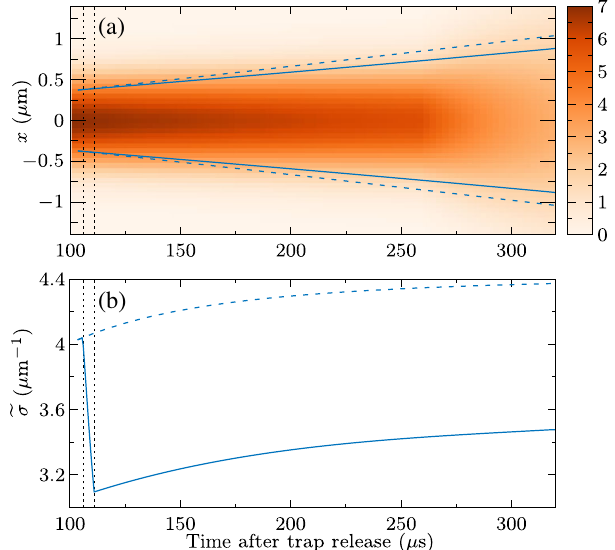
FIG. 6. Simulated expansion of a cloud of N ¼ 6600 atoms with (solid lines) and without (dashed lines) the interaction with a spatially homogeneous laser pulse. The pulse with a saturation s ¼ 708 × 10 − 6 and a detuning Δ ¼ þ 100 Γ starts after an 105 μ s and lasts for 5 μ s. In the trap, at expansion time t exp ¼ t ¼ 0 , the cloud has a Gaussian width a ⊥ ≈ 200 nm. (a) Evolution R R dy dz j ψ ð t; x; y; z Þj 2 of the average radial density ρ ⊥ ð t; x Þ ¼ (in 1000 atoms = μ m; see the color scale on the right); the lines indicate the width σ of a fitted Gaussian ∼ exp ½ − x 2 = ð 2 σ 2 Þ(cid:2) . (b) Transverse width of the Fourier transformed wave functions, ˜ ρ ⊥ ð t; q x Þ ¼ dashed vertical lines indicate the interaction time with the light pulse. We see that the width of the cloud does not change during the pulse, but the width of its Fourier transform (its momentum distribution) does. During the interaction, the wave function accumulates a position-dependent phase, which explains why the widths in real and Fourier space are reduced despite the otherwise free